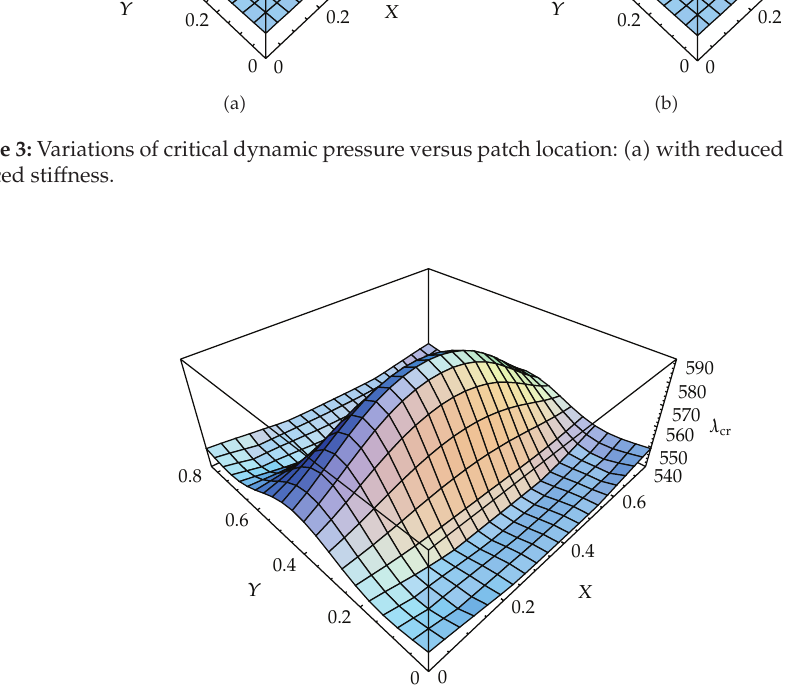
Figure 4: Variations of critical dynamic pressure versus patch location for a simply supported plate with dimensions a (cid:9) 0 . 4m, δ (cid:9) 4 /